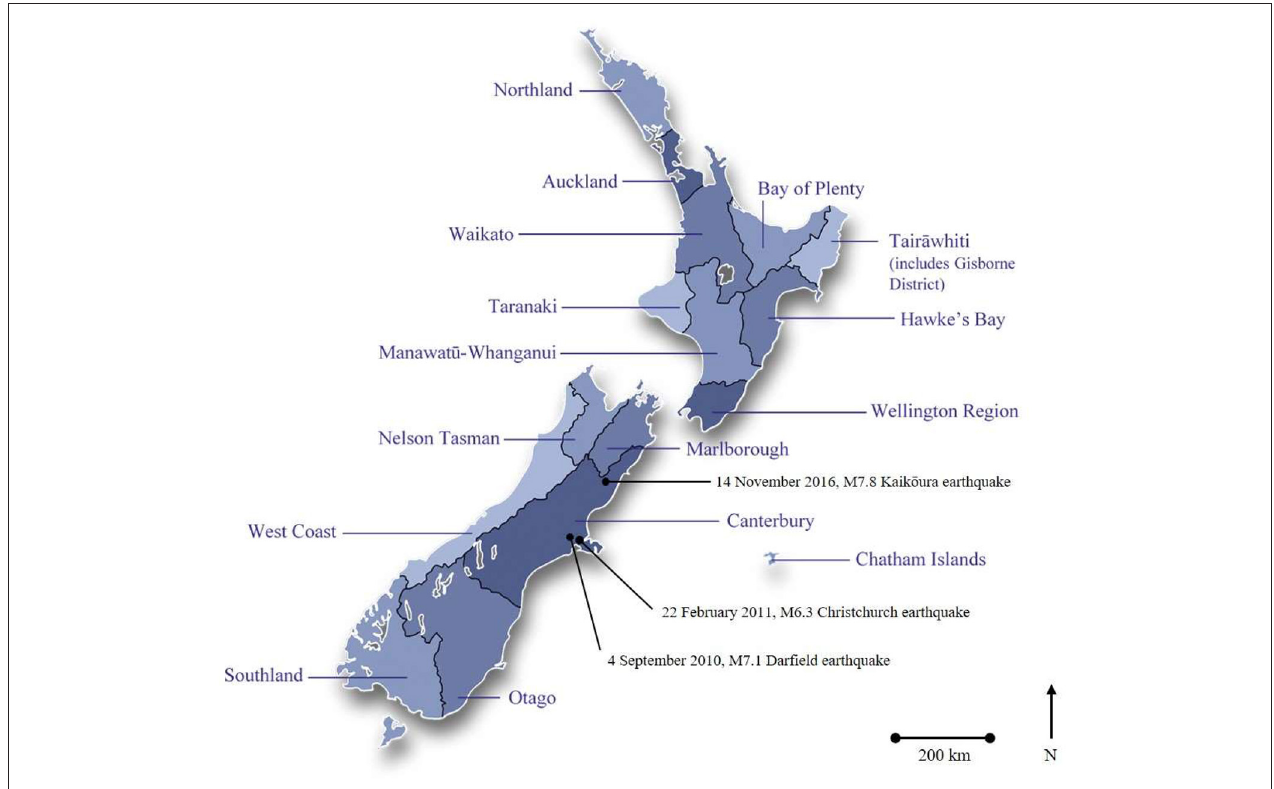
FIGURE 1 | Map of Aotearoa New Zealand showing regional areas as defined by Civil Defence Emergency Management boundaries (National Emergency Management Agency, 2013), the locations of the Darfield and Christchurch earthquakes (from the 2010–11 Canterbury Earthquake Sequence) and the location of the 2016 Kaikoura earthquake ( GNS Science, 2016).